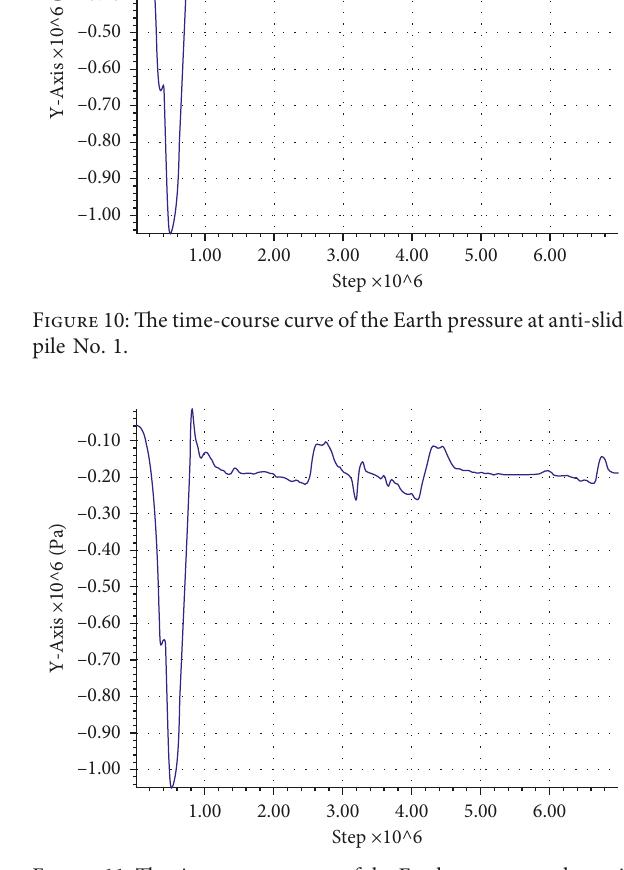
Figure 11: The time-course curve of the Earth pressure at the anti- slide pile No.